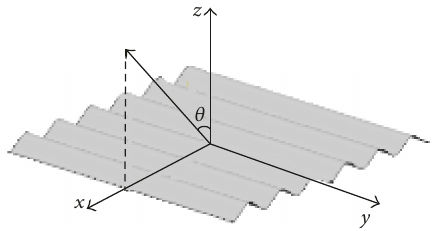
Figure 3: Illustration of a single frequency sinusoidal wave model.